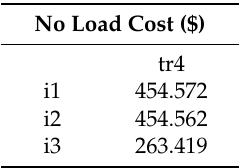
Table A8. Fixed production cost for unit i ($): a( i )